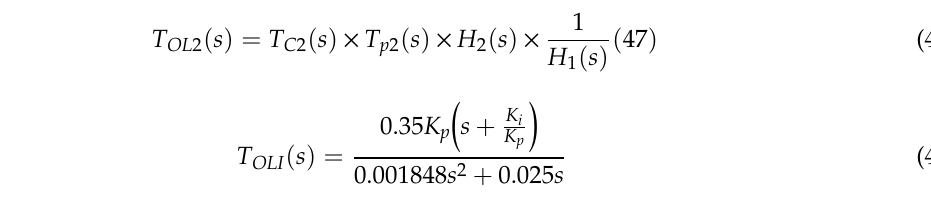
Figure 11. Bode plot of uncompensated plant in voltage control loop: PM = 94.1° at 1990 rad/s.